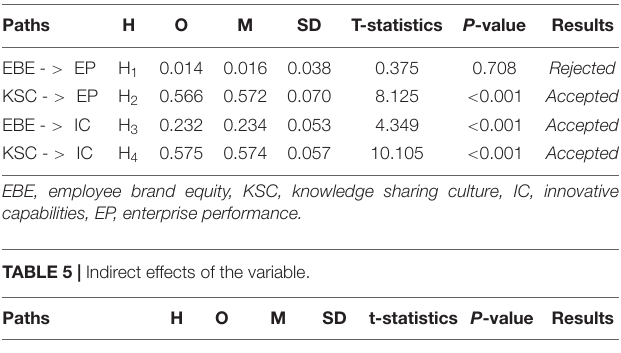
TABLE 4 | Direct effects of the variable.